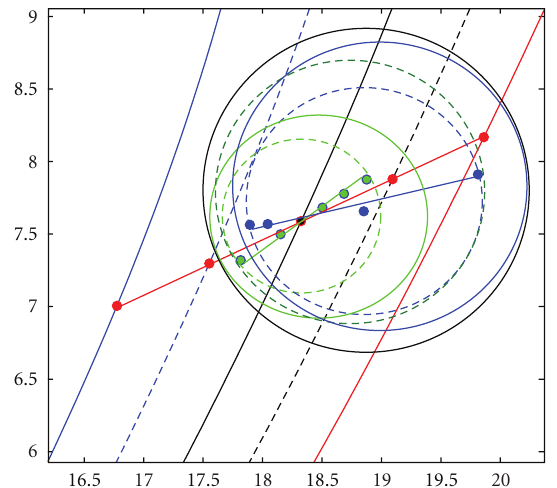
Figure 7: E ff ect of temperature on the sensitivity of the impedance response to cathode thickness and porosity: the dotted circles correspond to the uncertainties at room temperature (298K) and the solid circles correspond to equivalent values at low temperature